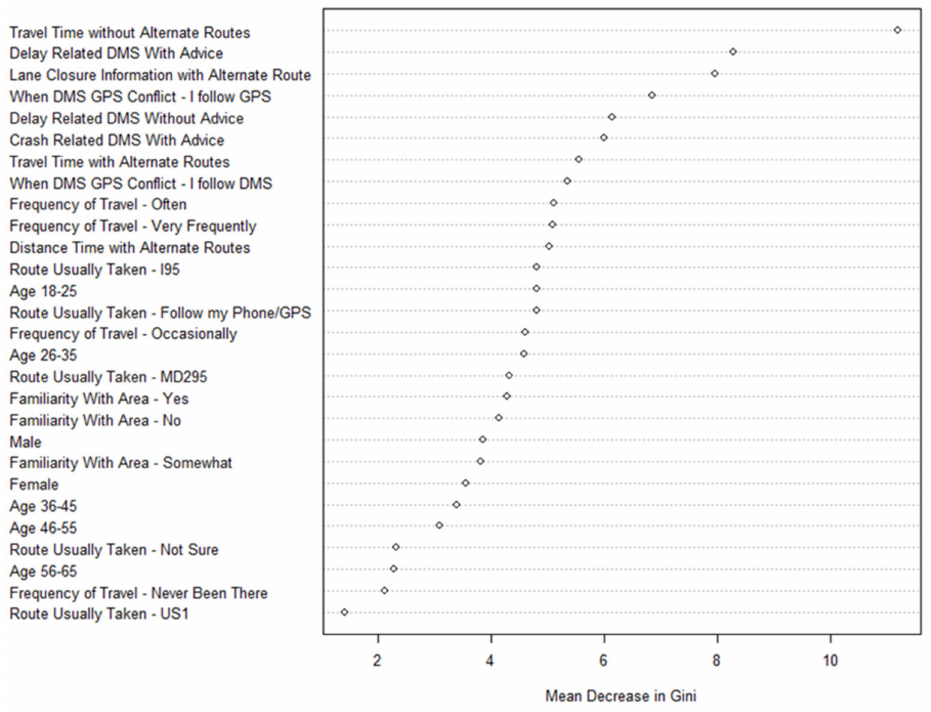
Figure 7. Plot of variable importance for diversion by MDG